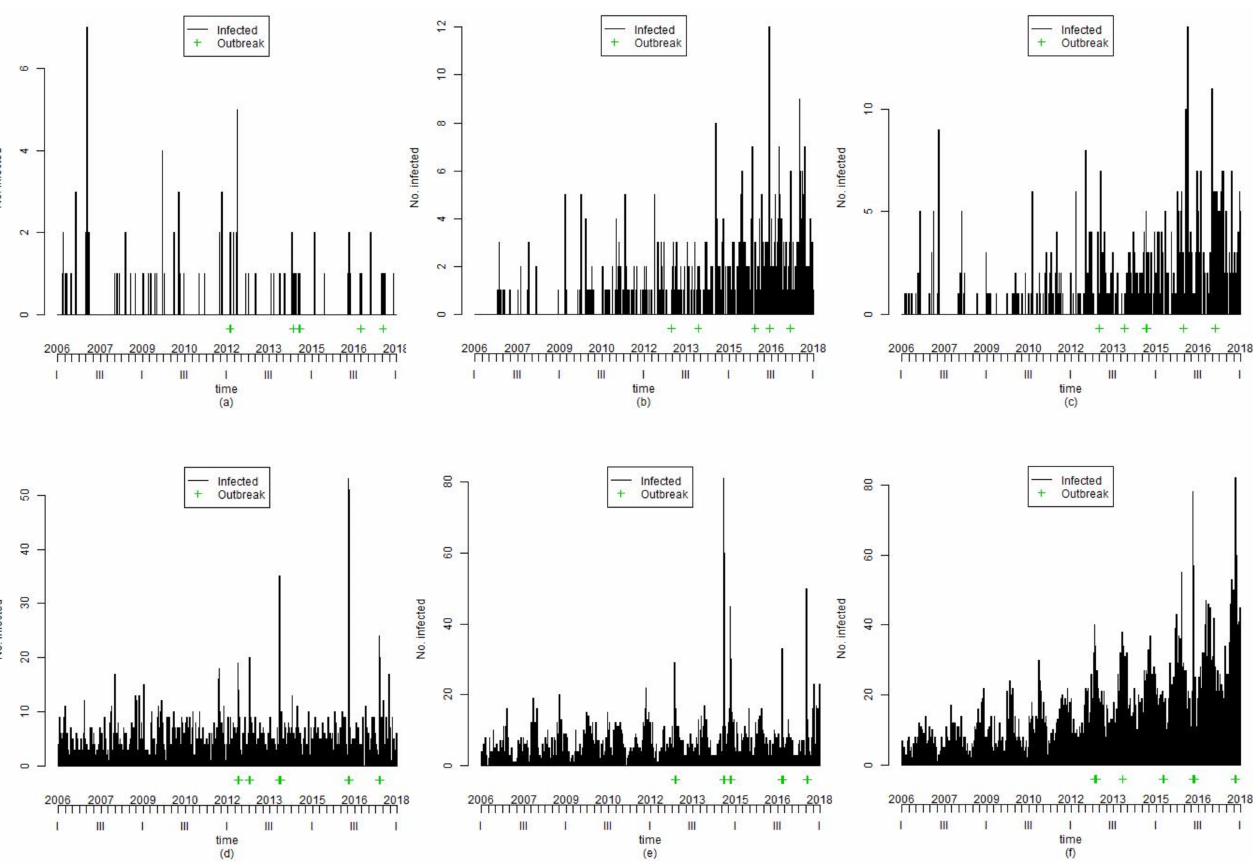
Figure 2. Examples of simulated data: ( a ) Scenario 8; ( b ) Scenario 10; ( c ) Scenario 12; ( d ) Scenario 13; ( e ) Scenario 15; and ( f ) Scenario 17. In each graph, the x-axis represents time, the y-axis represents the number of infections, and the green-colored plus sign resembles